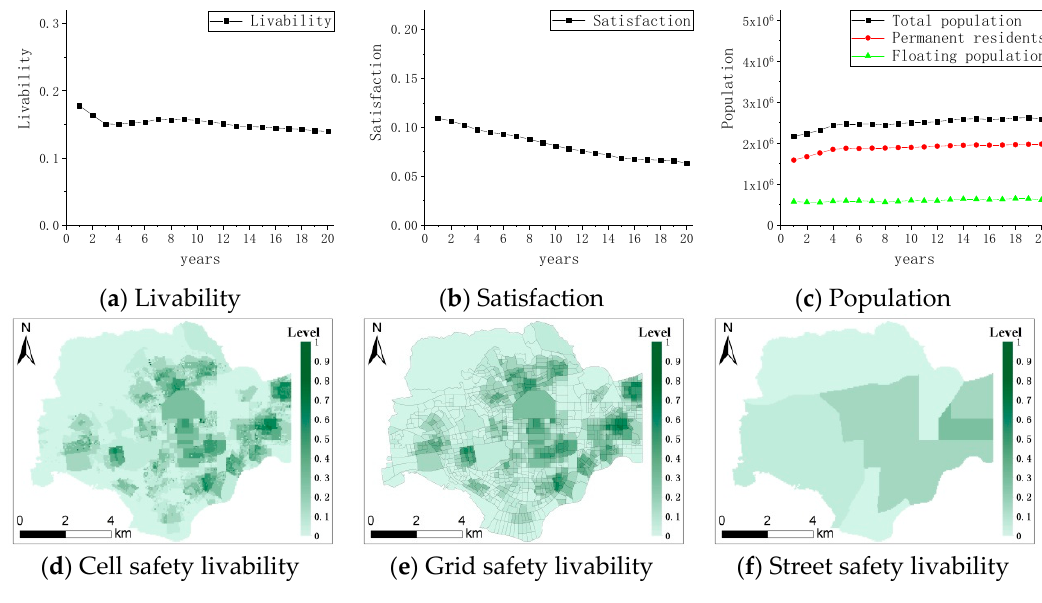
Figure 13. Scenario 3 results.